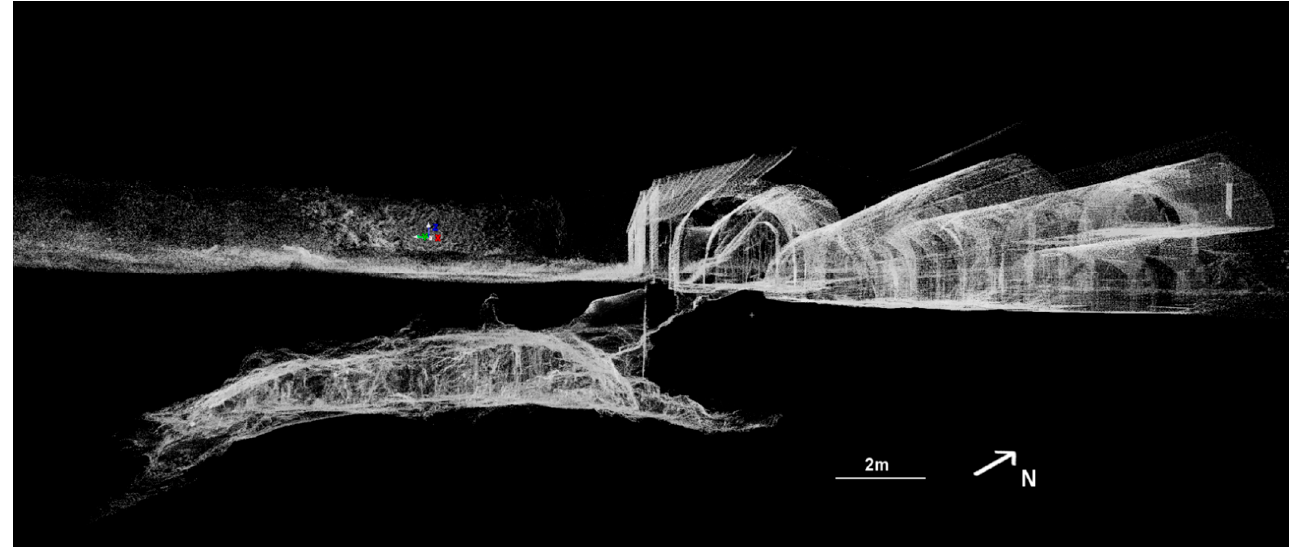
Figure 5. The 3D model of the complex structure of Iazzo Sant’Angelo showing the connection between the cave and the buildings and the rock thickness over the cavity. It is evident that a chimney rises up toward the ground level.